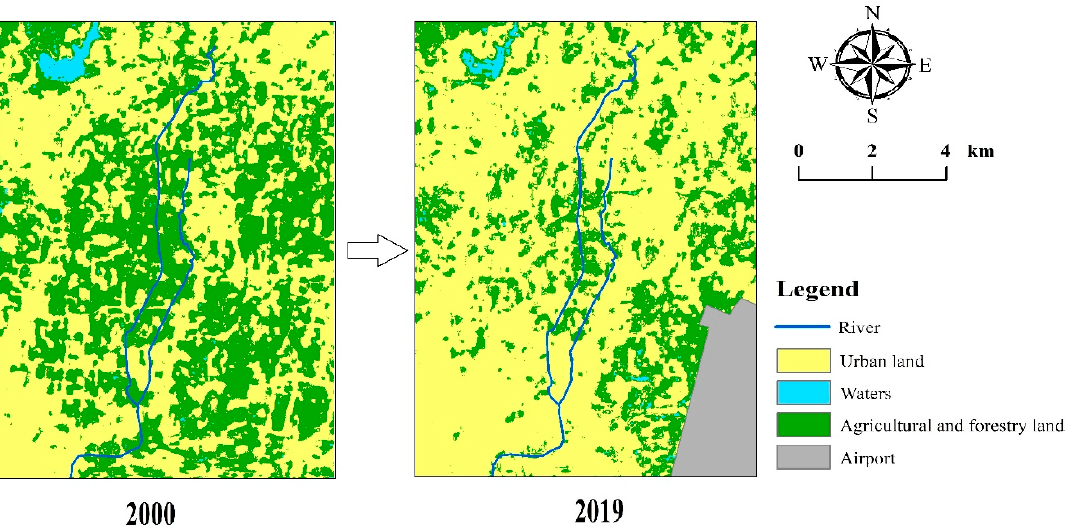
Figure 2. Land-use type in 2000 and 2019.